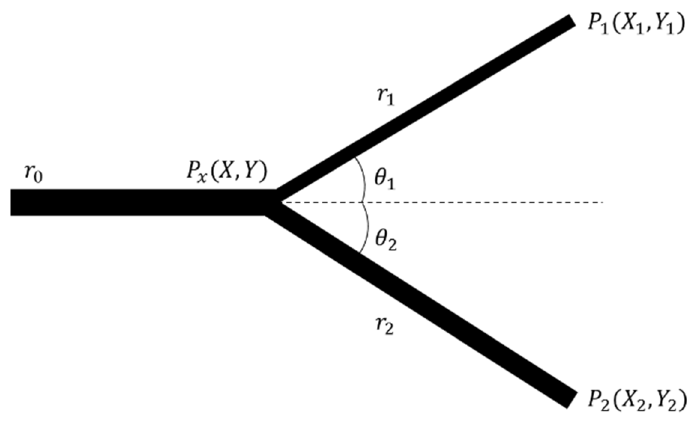
Figure 4. Cooling channel junction determination methodology.